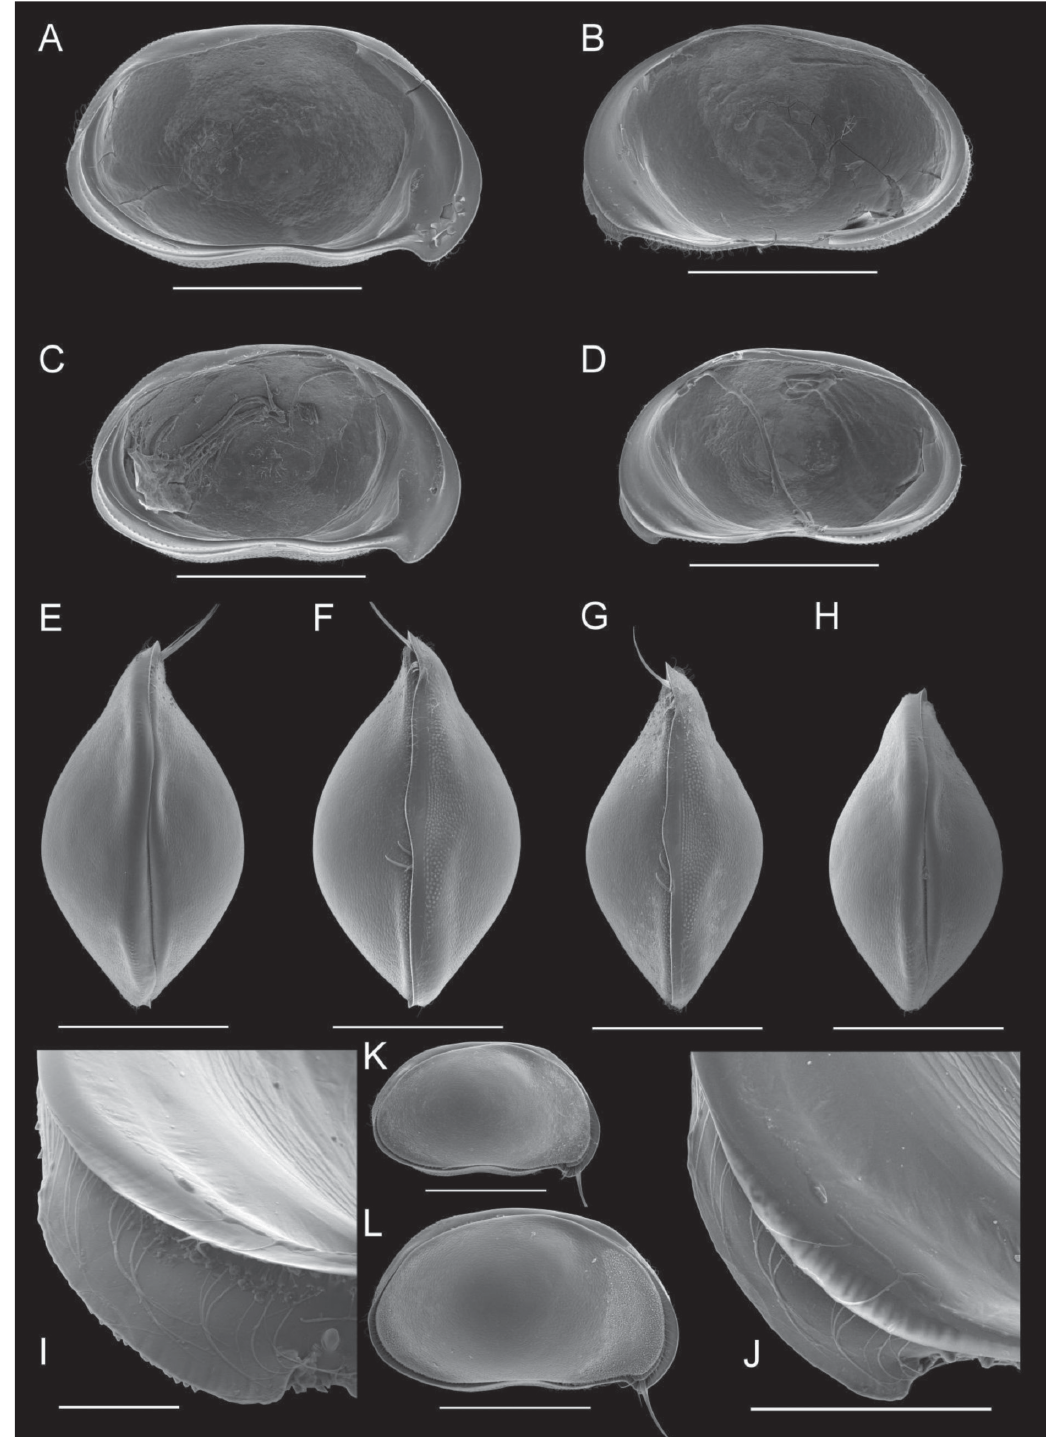
Fig. 12. Bennelongia cuensis sensu lato A-B, D-L from unnamed pool near Kilcowera Station, QLD; C from island claypan on Bloodwood Station NSW. A . ♀, LVi (W40053). B . ♀, RVi (W40053). C . ♂, LVi (W40002). D . ♂, RVi (W40052). E . ♀, Cp dorsal (W40059). F . ♀, Cp ventral (W40058). G . ♂, Cp ventral (W40056). H . ♂, Cp dorsal (W40055). I . ♂, RVi detail anteriorly (W40052). J . ♂, RVi detail anteriorly (W40052). K . ♂, CpRl (W40054). L . ♀, CpRl (W40057). Scales: A-H, K-L = 1000 μm, J = 200 μm, I = 100